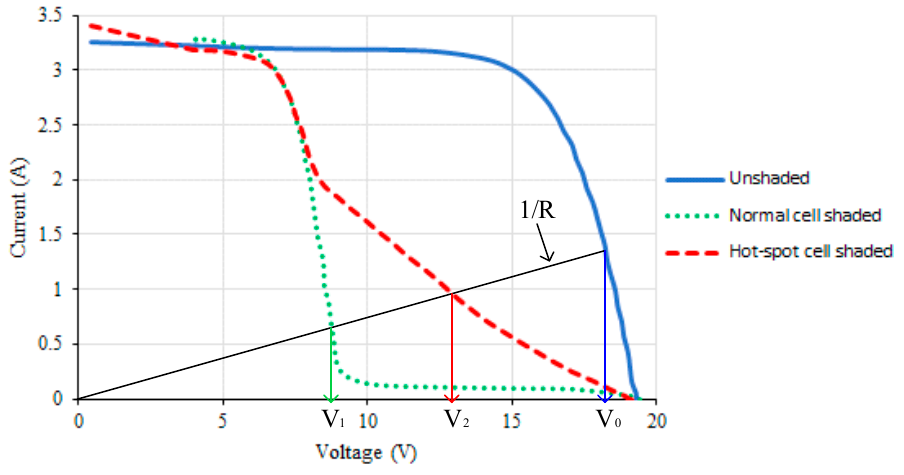
Figure 9. I - V characteristics of normal cell shaded condition and Defective cell shaded condition.